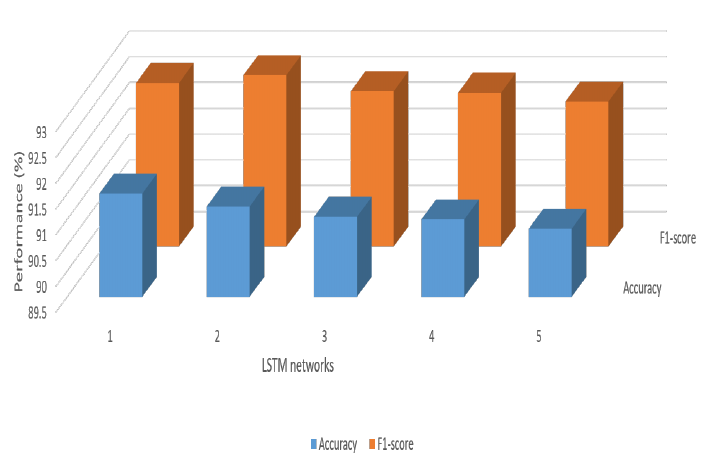
Figure 7. Best-performing 5 LSTM models. Table 3. GALSTM-FDP: Network parameters of top 5 networks based on percentage of accuracy and